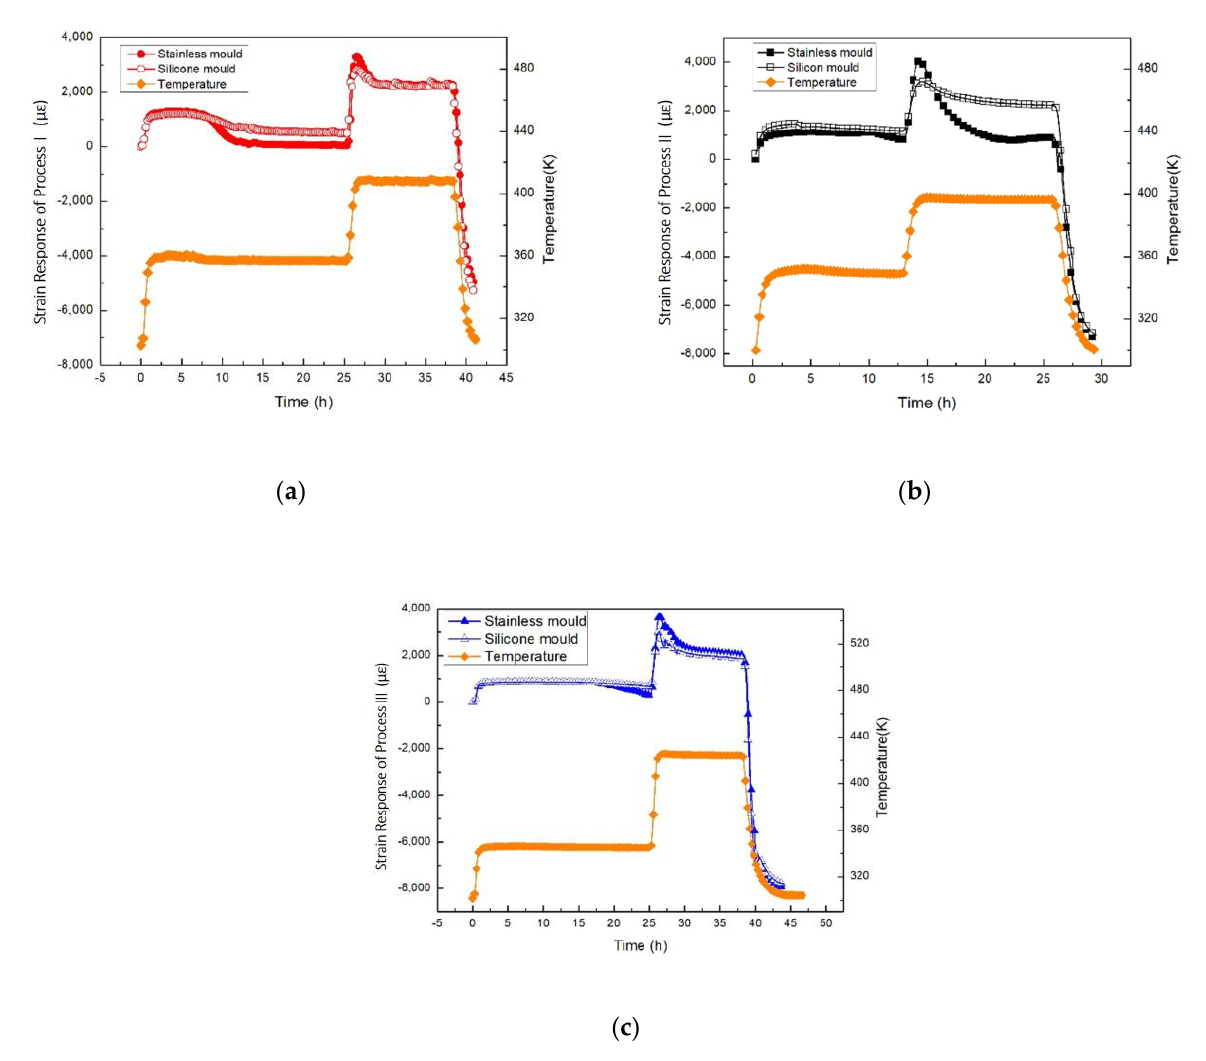
Figure 7. Strain responses of epoxy resin cured in two moulds: ( a ) Strain comparison of Process I in two moulds; ( b ) Strain comparison of Process II in two moulds; ( c ) Strain comparison of Process III in two moulds.